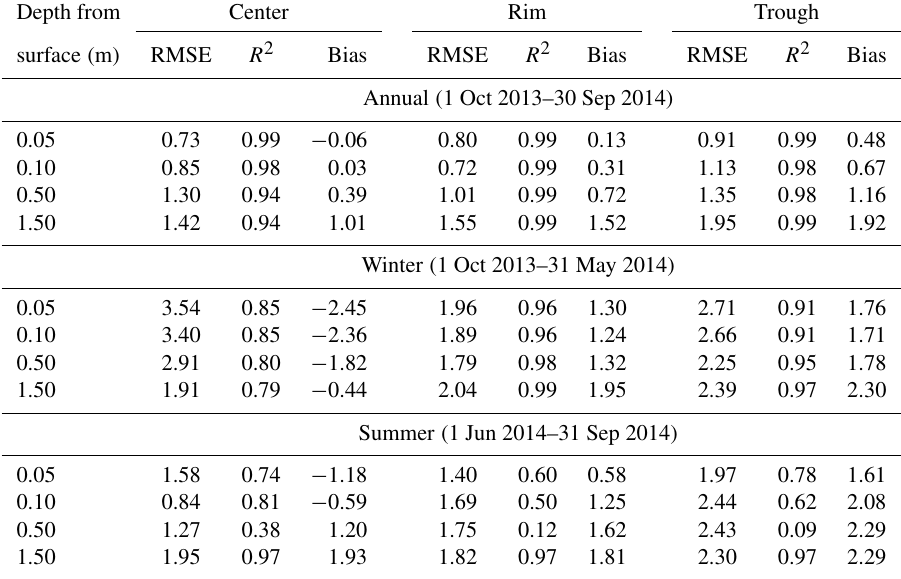
Table 3. Model performance statistics at Site A compared to observed soil temperatures (for annual, winter and summer periods). The model shows higher bias during the summer season compared to winter. Depth from Center Rim Trough